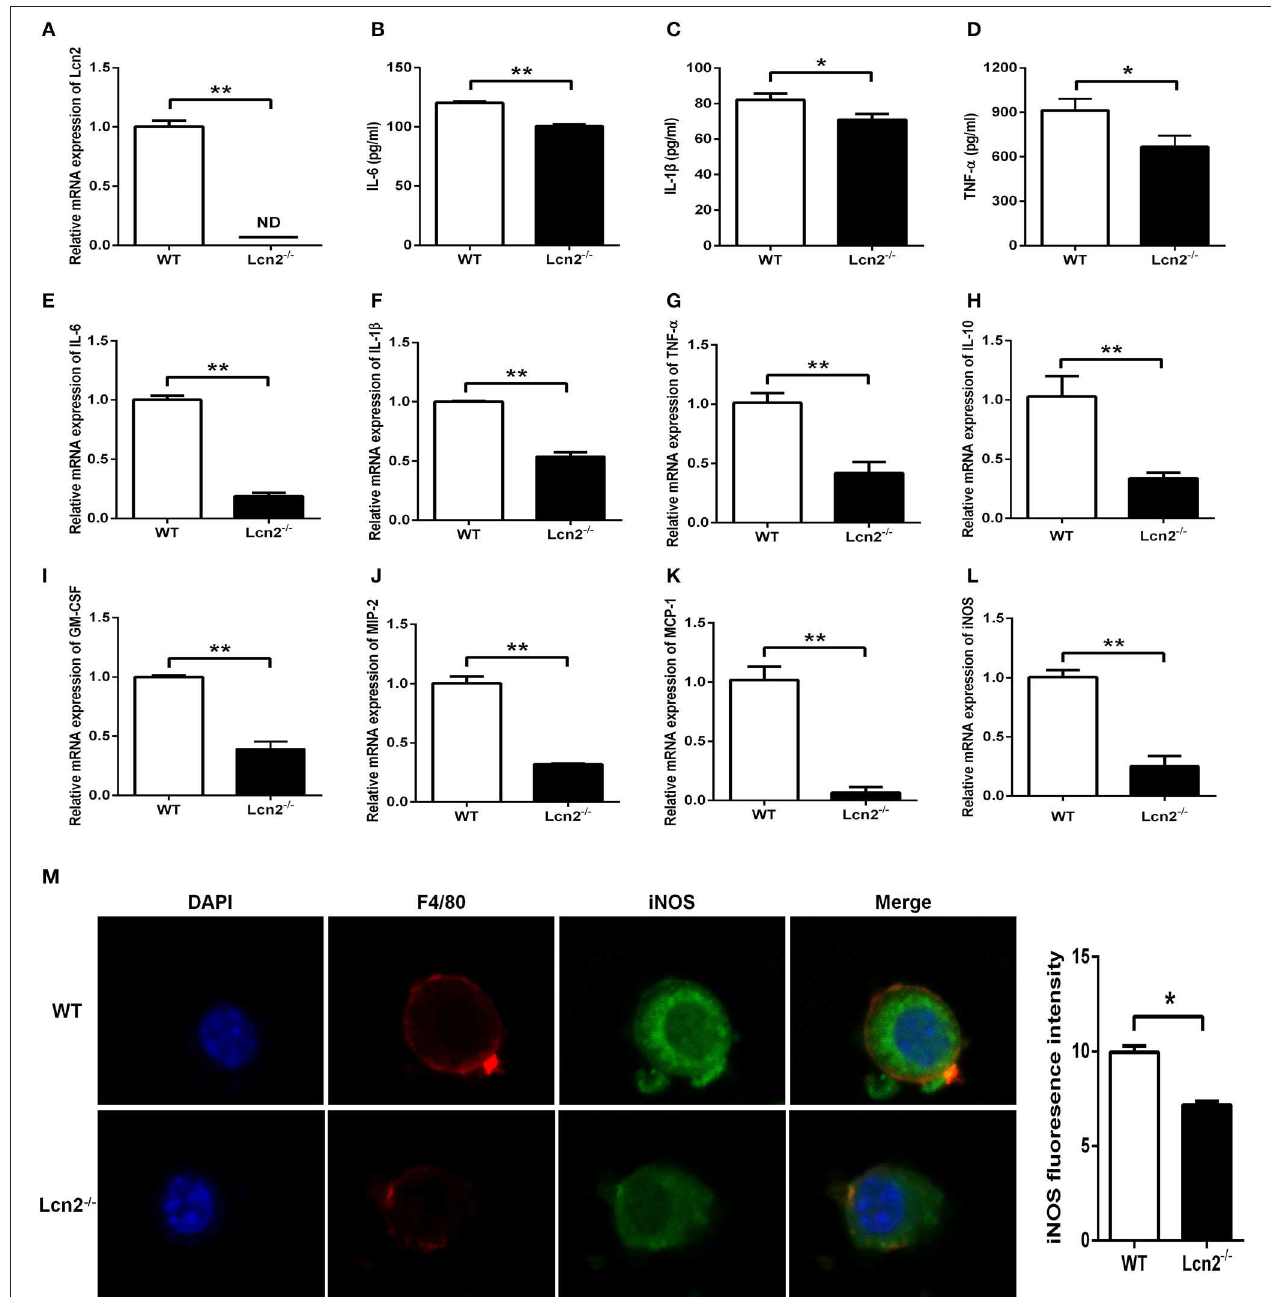
FIGURE 5 | Decreased expression of inflammatory cytokines produced by lipocalin 2-deficient ( Lcn2 − / − ) macrophages. (A) Real-time PCR analysis of Lcn2 mRNA expression levels in the E. coli O157:H7-infected primary bone marrow-derived macrophages (BMDMs) from wild-type (WT) and Lcn2 − / − mice. (B–D) ELISA analysis of interleukin (IL)-6, IL-1 β , and tumor necrosis factor (TNF)- α levels in the culture medium of the E. coli O157:H7-infected BMDMs from WT and Lcn2 − / − mice. (E–L) Real-time PCR analysis of cytokine mRNA expression levels in the E. coli O157:H7-infected pBMDMs from WT and Lcn2 − / − mice. (M) The infected BMDMs of WT and Lcn2 − / − mice were subjected to staining with rabbit monoclonal antibody iNOS, rat monoclonal antibody F4/80, Alexa Fluor 488 goat anti-rabbit IgG, and Alexa Fluor 647 goat anti-rat IgG in blocking buffer (1:200) and observed by fluorescence microscopy. Values are average means of triplicate experiments with two mice used for the isolation of BMDMs per genotype per experiment. Error bars depict SEM. Results are expressed as means ± SEM. P < 0.05 was considered statistically significant. * P < 0.05 and ** P < 0.01.